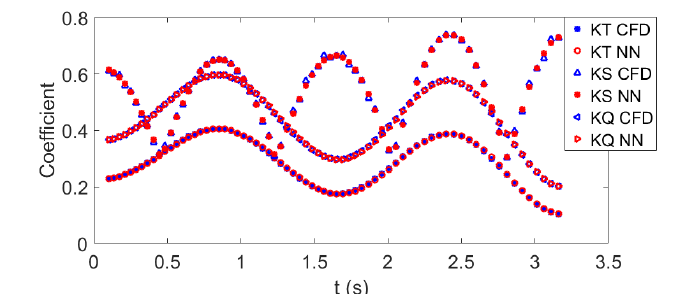
Figure 4. Coefficients as a function of time for open water training using the neural network.